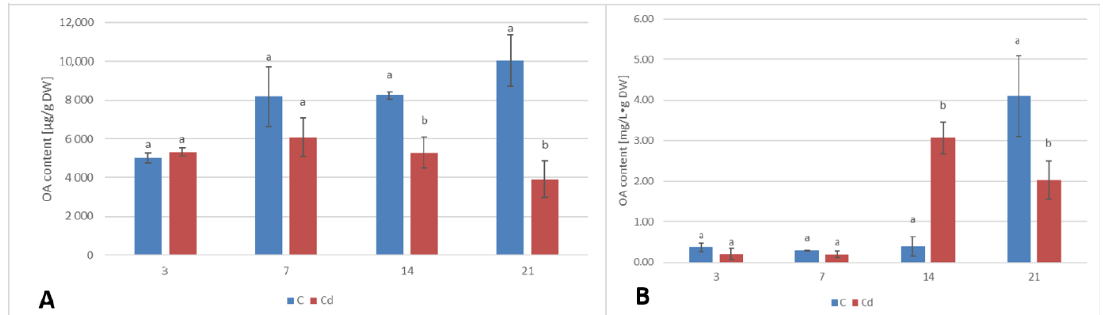
Figure 10. The effect of cadmium treatment on the content of saponins in the root tissue ( A ) and saponins released to the culture medium ( B ). Bars which do not share a common letter are significantly different ( p < 0.05).